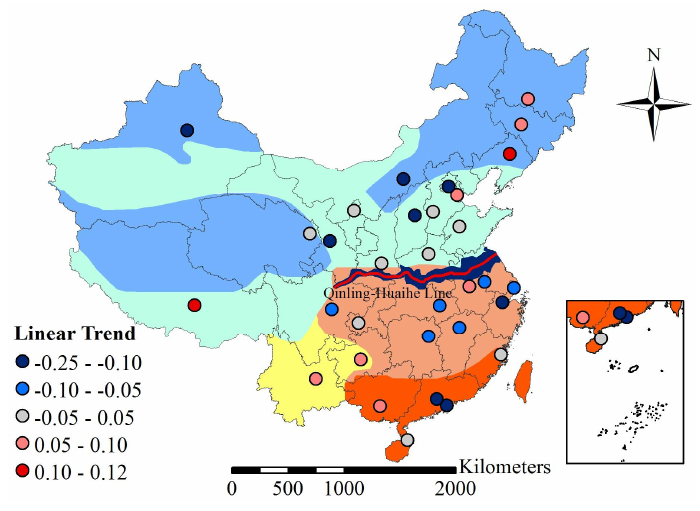
Figure 7. The change rate, or the linear trend of the seasonal averaged daytime SUHIIs, in summer from 2003 to 2013.